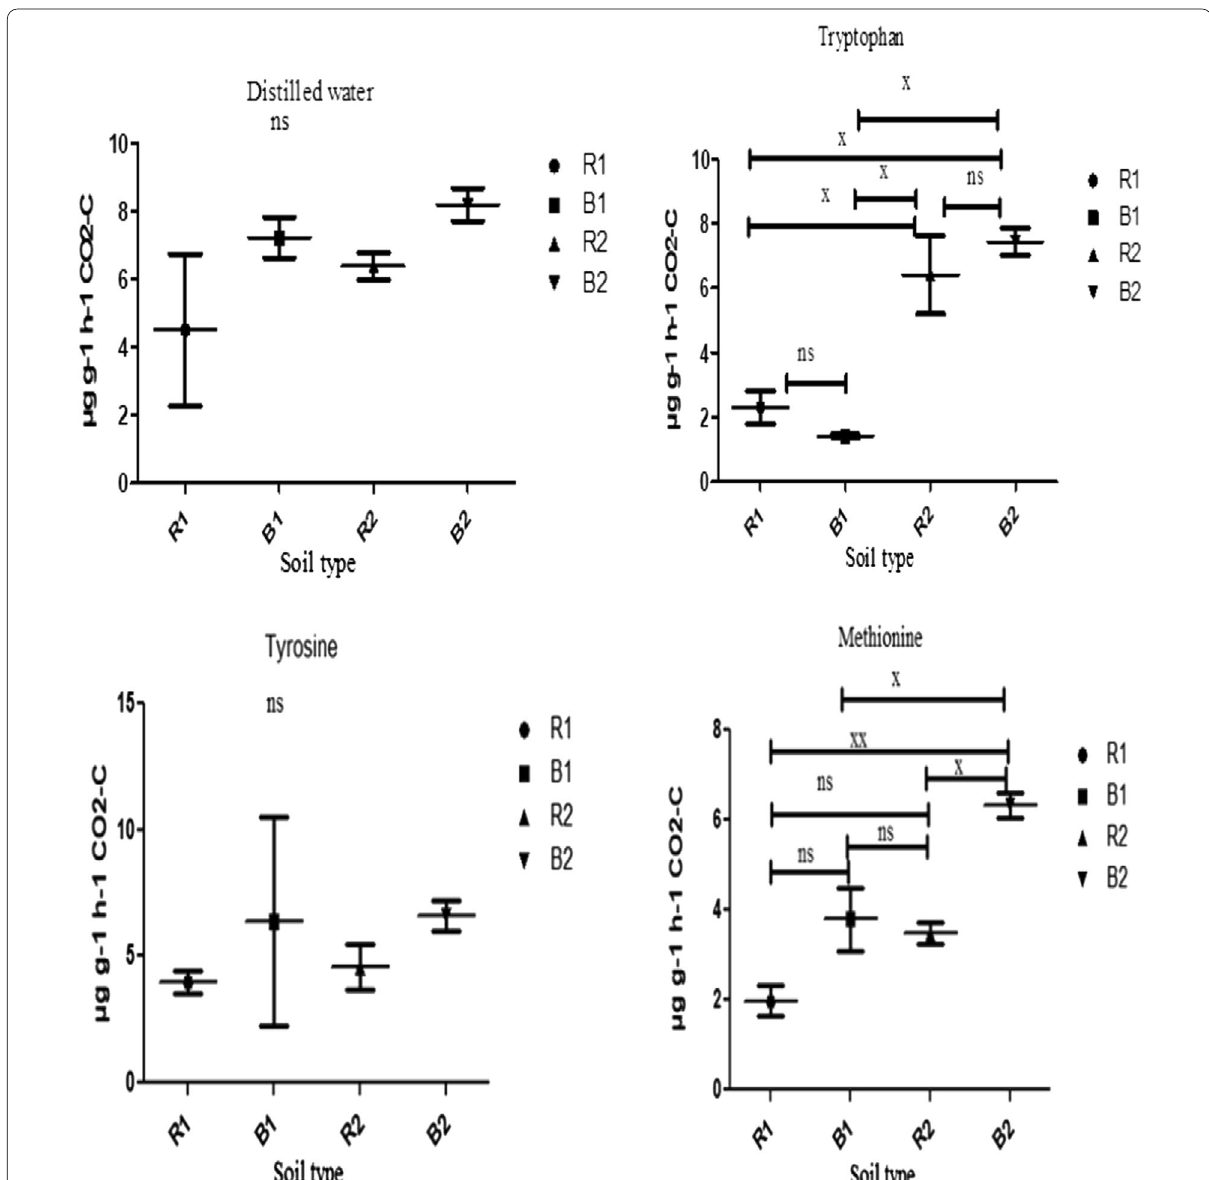
Fig. 6 Effects of soil type on soil functional properties as measured for distilled water i.e. control, tryptophan, tyrosine and methionine using MicroResp assay. Number of replicates (n) 2. Data represent mean SE, ns not statistically significant; x statistically significant; xx more statistically = ± significant; R1 Ditsobottla rhizosphere soil; B1 Ditsobottla bulk soil; R2 Kraaipan rhizosphere soil; B2 Kraaipan bulk